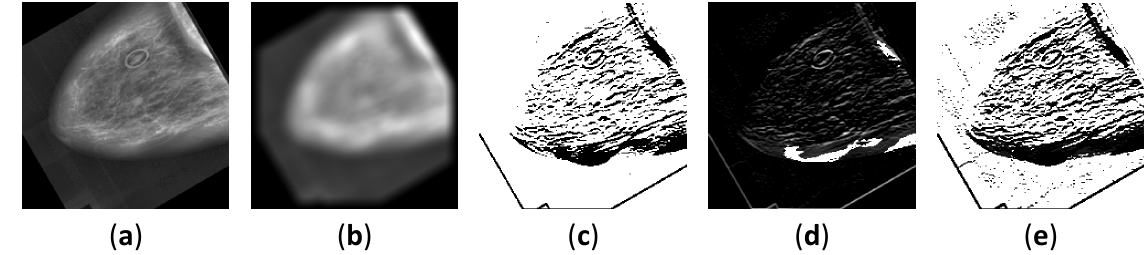
Figure 13. Demonstration using DDSM right breast masses benign cancer with CC view to present ( a ) original image, ( b ) blurred image, ( c ) edge pixel image, ( d ) smooth pixel image, and ( e ) texture pixel image.